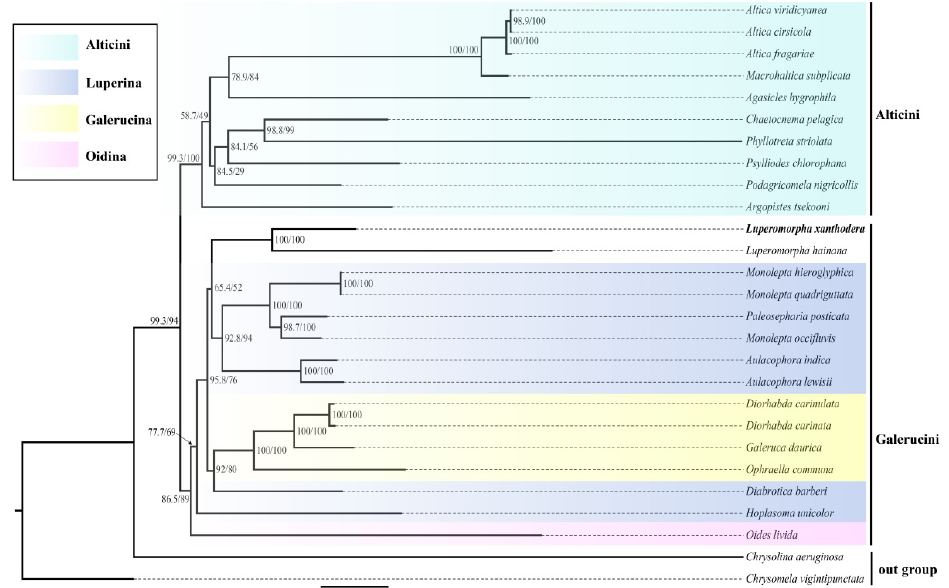
Figure 6. ML analysis was conducted using IQ-TREE with the dataset of amino acids of 13 PCGs. Note: Name in black bold show the phylogenetic position of Luperomorpha xanthodera that we sequenced in this research. The numbers on the nodes are the SH-aLRT support (%) and ultrafast bootstrap support (%).